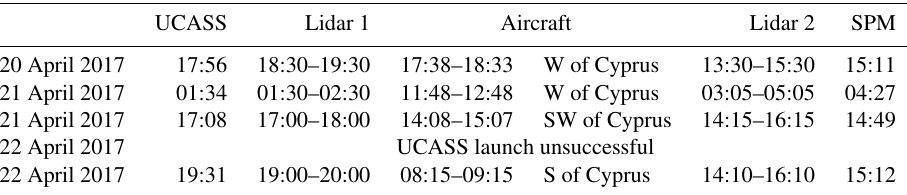
Table 1. Dates and times (UTC) of UCASS launches, aircraft profiles (together with location of observation), and measurements with lidar and sun photometer (SPM) used in this study. UCASS units were launched from Paphos except for the launch at 01:34UTC on 21 April 2017 which was performed next to the lidar site at Limassol. Lidar 1 refers to the time period used for the comparison of AOD and extinction coefficients in Figs. 1 and 8, respectively. Lidar 2 marks the time period used for the combined lidar–SPM retrievals with GARRLiC in Fig. 6.